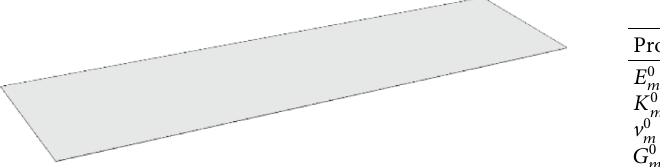
Figure 9: Geometrical model of the panel. Table 2: The parameters used in the curing kinetics model.